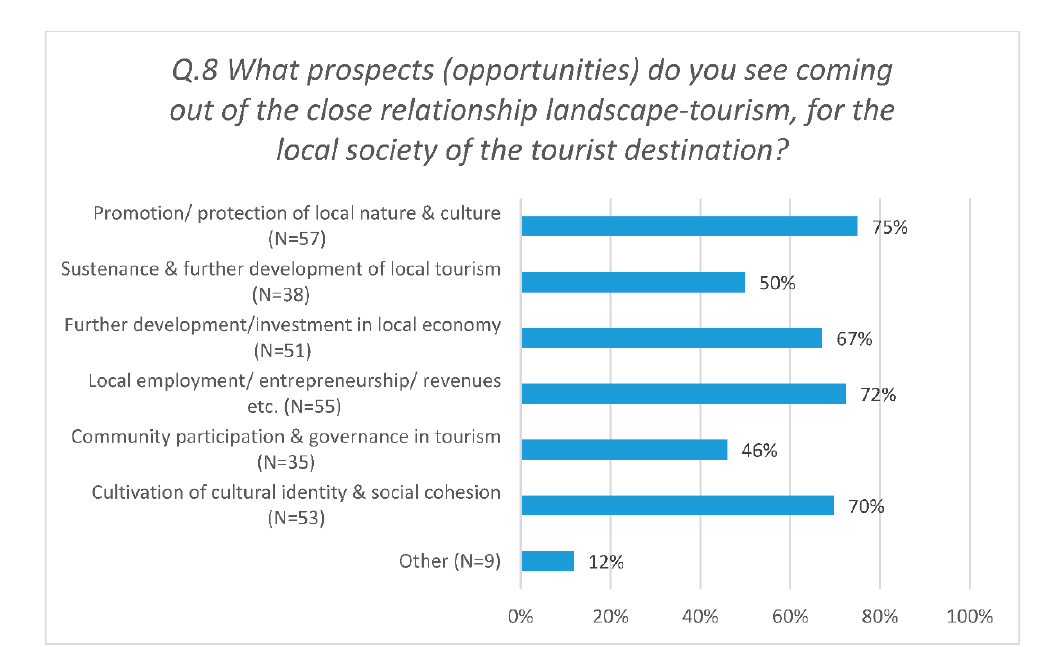
Figure 6. Prospects of the tourism–landscape relationship for the local society of the tourist destination.